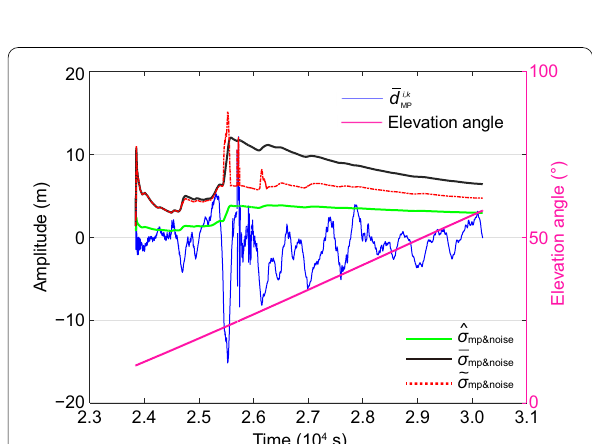
Fig. 2 An example of estimation results of pseudorange